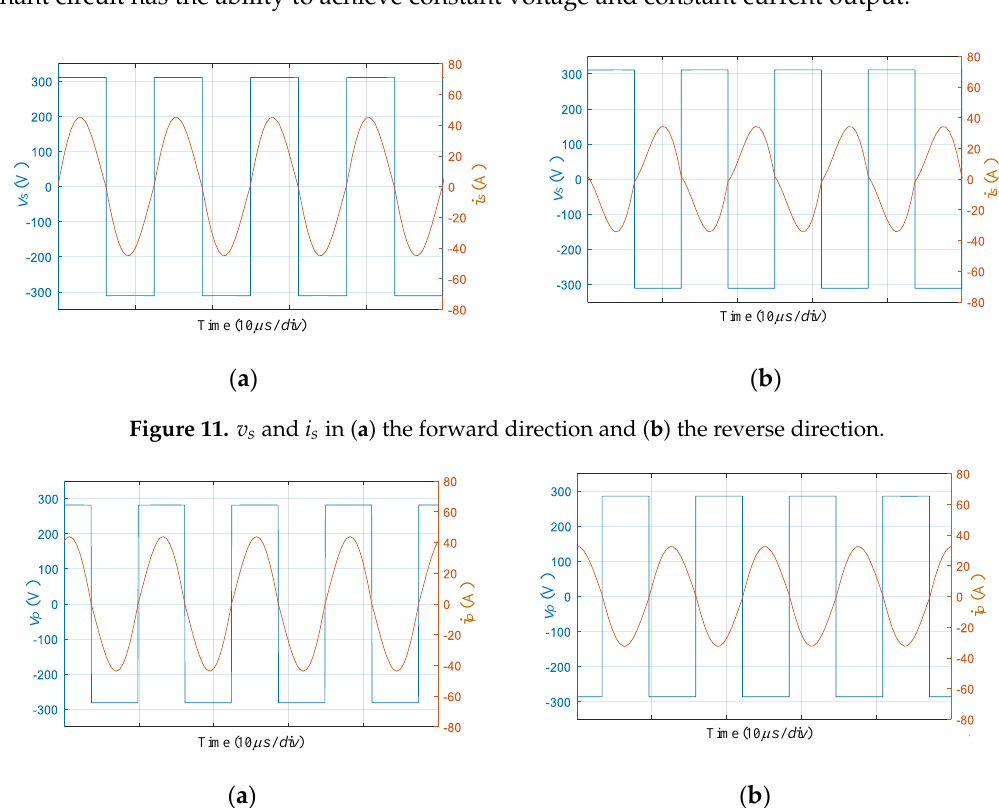
Figure 12. v p and i p in ( a ) the forward direction and ( b ) the reverse direction.